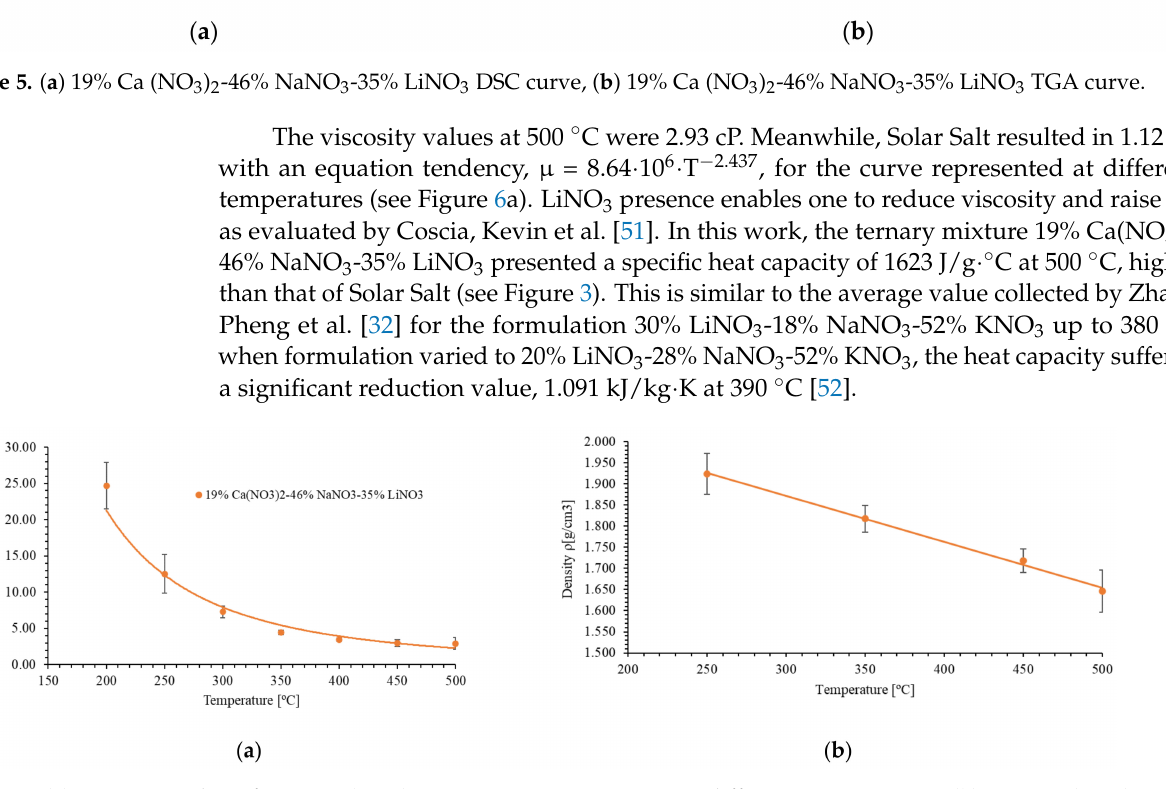
Figure 6. ( a ) Viscosity value of 19% Ca (NO 3 ) 2 -46% NaNO 3 -35% LiNO 3 at different temperatures. ( b ) 19% Ca (NO 3 ) 2 - 46% NaNO 3 -35% LiNO 3 density values from 250 ◦ C up to 500 ◦